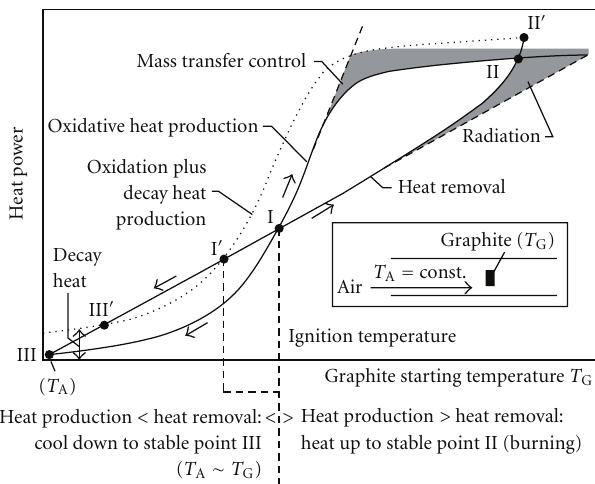
Figure 1: Heat balances in an exemplary graphite burning